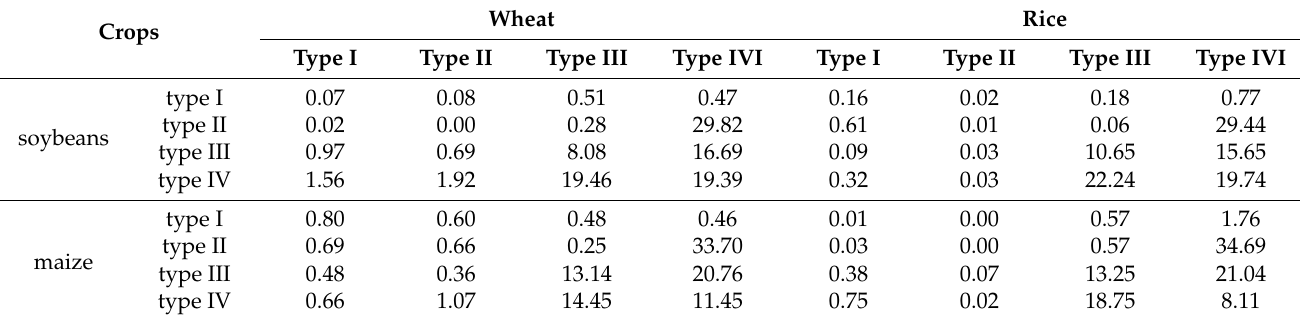
Table 5. The transfer matrix of different types between feed grain and food grain